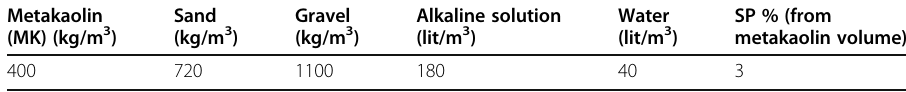
Table 3 Mix properties of geopolymer concrete Metakaolin (MK) (kg/m 3 )